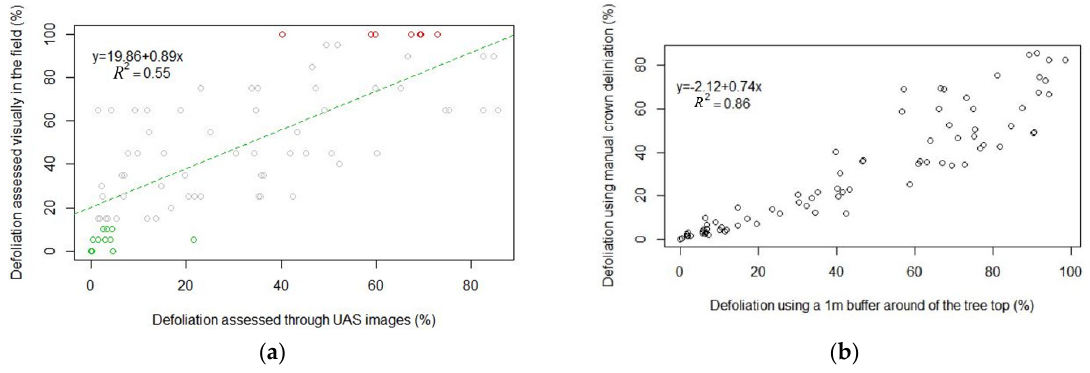
Figure 5. ( a ) Linear regression model between defoliation measured in the field and through UAS images in Torregassa forest site; ( b ) Defoliation using a 1 ‐ m buffer around the tree top and using manual crown delineation. n = 81. Red = completely defoliated; grey = infested; green = non ‐ infested.